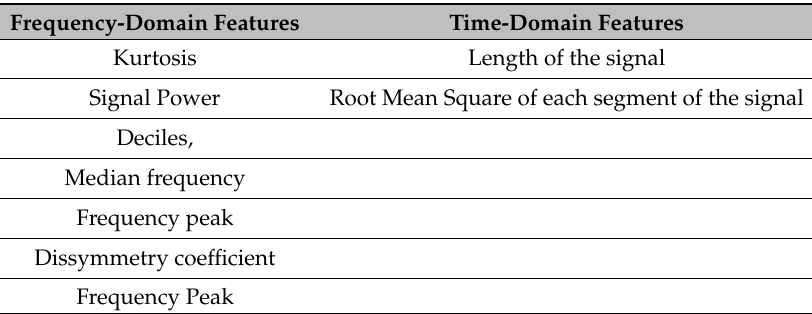
Table 1. Summary of the Extracted